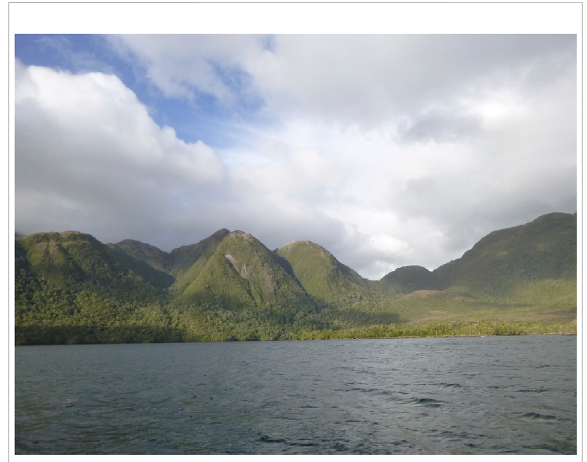
FIGURE 2 Coastal modelling by the ice sheet of the Last Glacial Maximum. Steep coasts and fjords can be observed throughout the West Patagonia. The ground rises hundreds of meters and